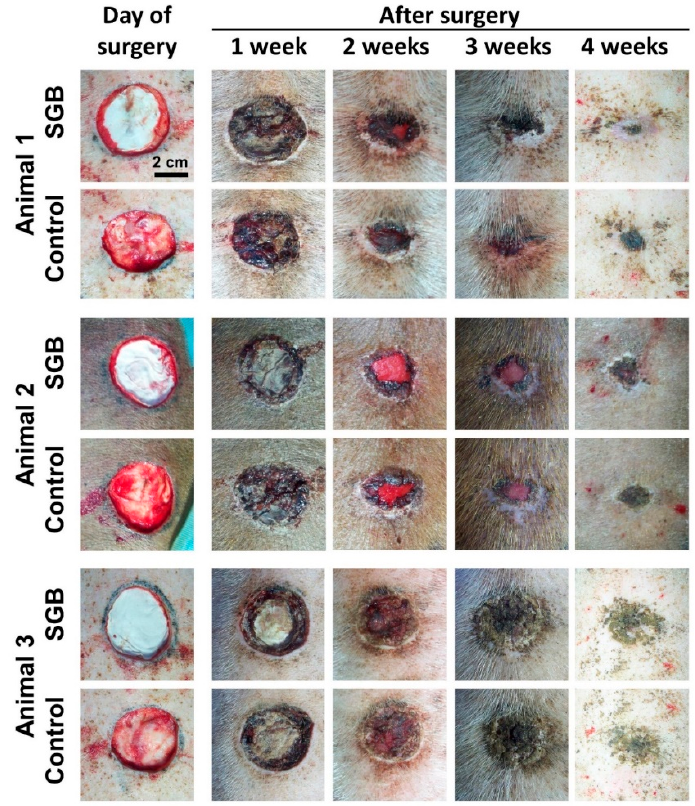
Figure 2. In vivo trial of wound healing process in porcine model (Bar 2 cm).